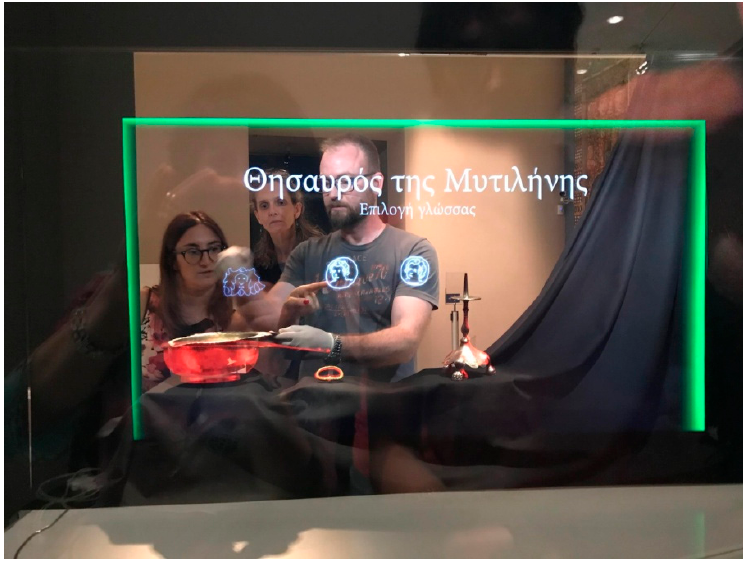
Figure 24. Depth of the showcase and positioning of the objects close to the back side, during the installation set up of the Mytilene Treasure in Athens.